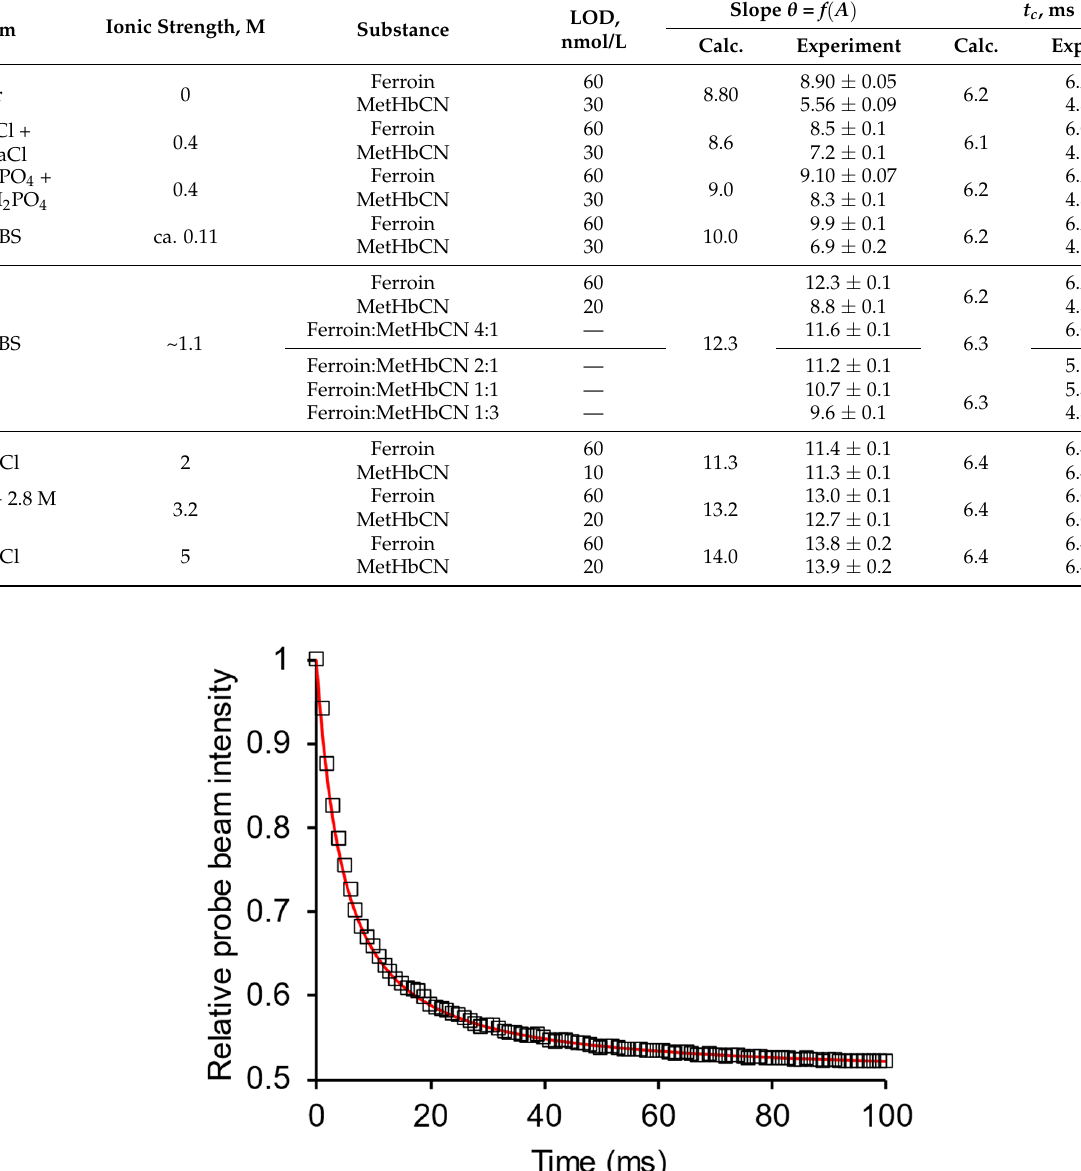
data (squares) in ethanol. Setup, TLS-60; excitation wavelength, 532.0 nm; excitation power, 40 mW.